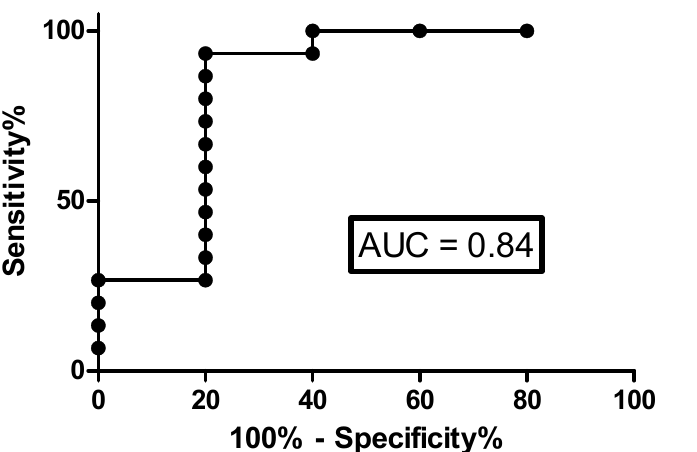
Figure 3. ROC curve for assessment of accuracy of CaNO in detecting CT lung abnormalities.